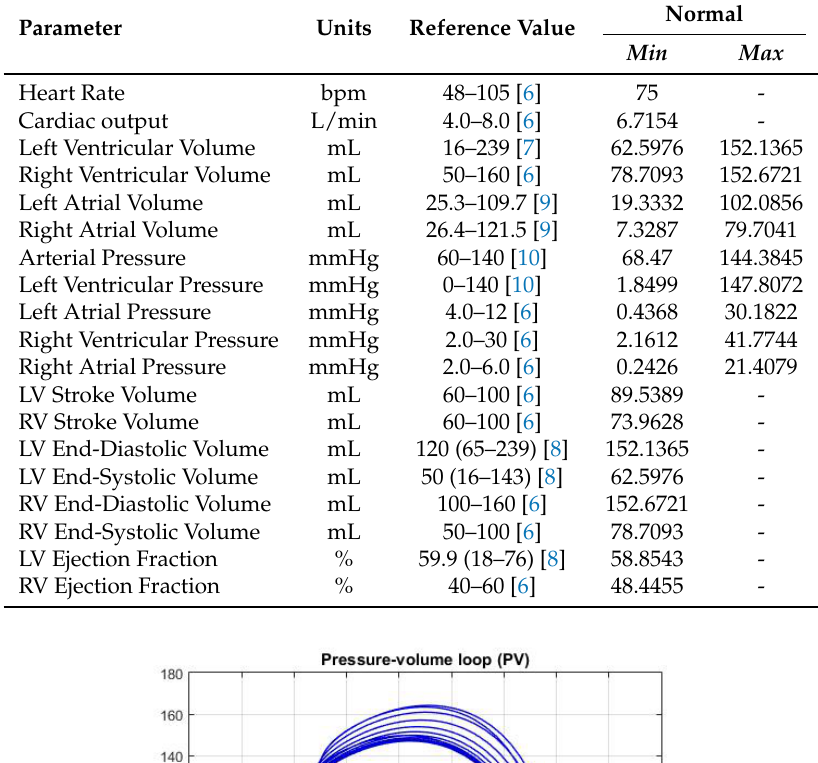
Table 1. Comparison of hemodynamic parameters between a healthy person and the Cardiovascular Simulation Tool (CVST-2) simulation.